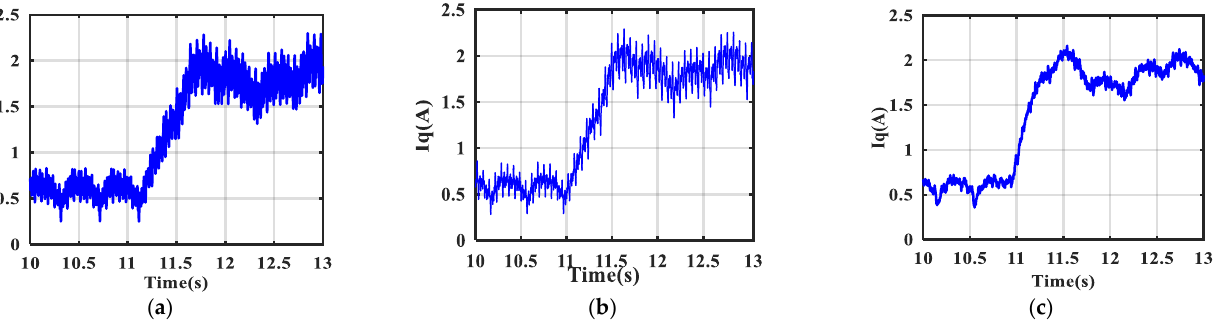
Figure 19. Experimental results of q -axis current during the load operation: ( a ) with a PI controller, ( b ) with a PIR controller and ( c ) with a Robust-TDOFR controller. Table 6. Experimental results under the operation of sudden